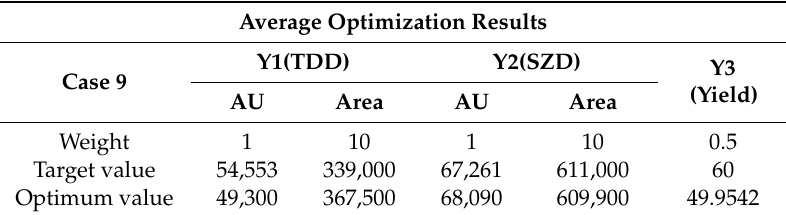
Table 7. Predicted values (PVs) and target values (TVs) of RE.